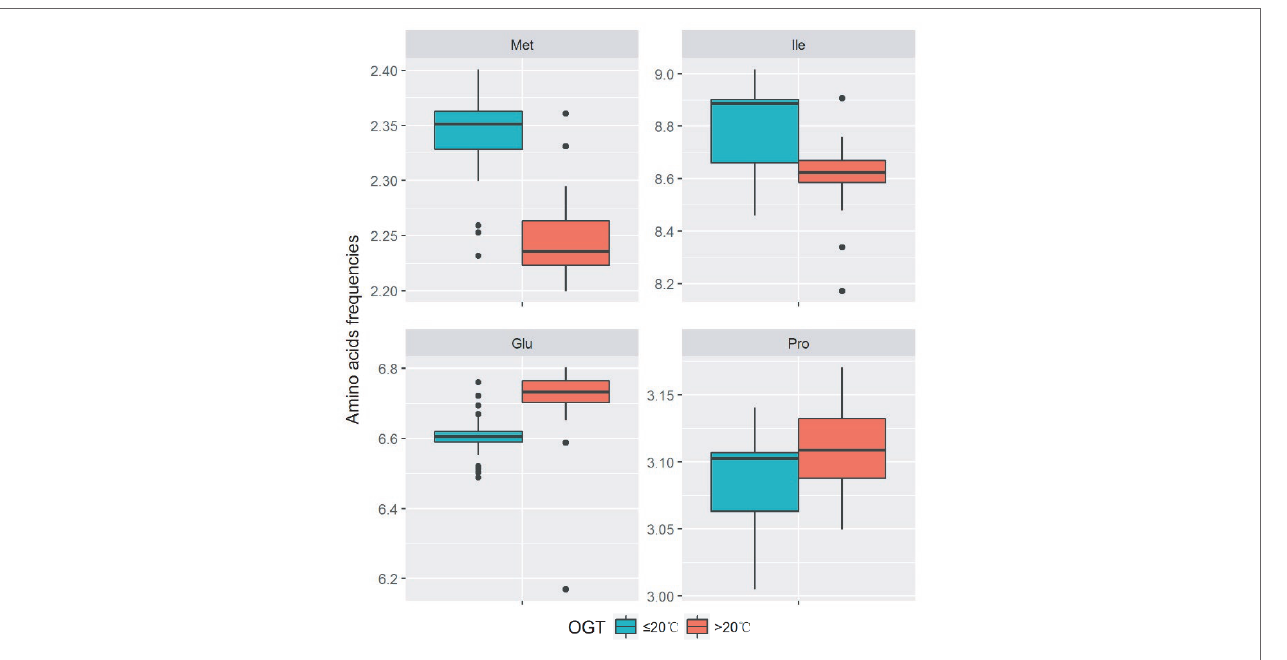
FIGURE 4 | Difference of amino acid residue frequencies between the two groups of strains with OGT ≤ 20 ° C and OGT > 20 ° C in the genus Flavobacterium . The boxplot was produced in “ggplot2” package implemented in R. The significant differences were identified using Student’s t